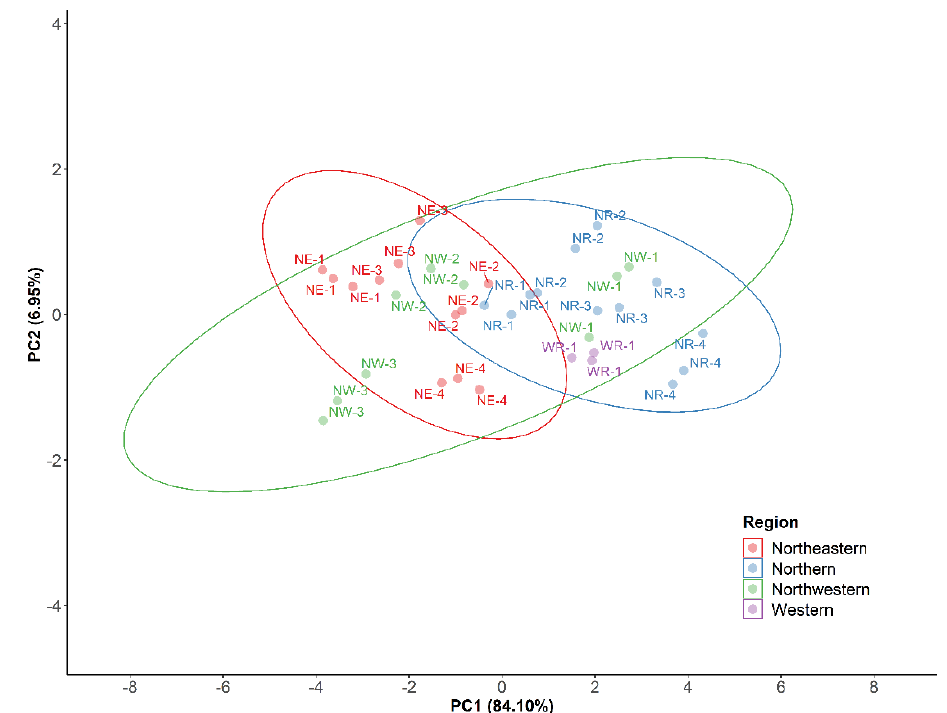
Figure 19. Graphic representation of the plane defined by the two first principal components (PC1 and PC2) deriving from the PCA analysis of C. longa rhizomes ( n = 12) contents. Regions: Northeastern (NE), Northern (NR), Northwestern (NW), Western (WR).